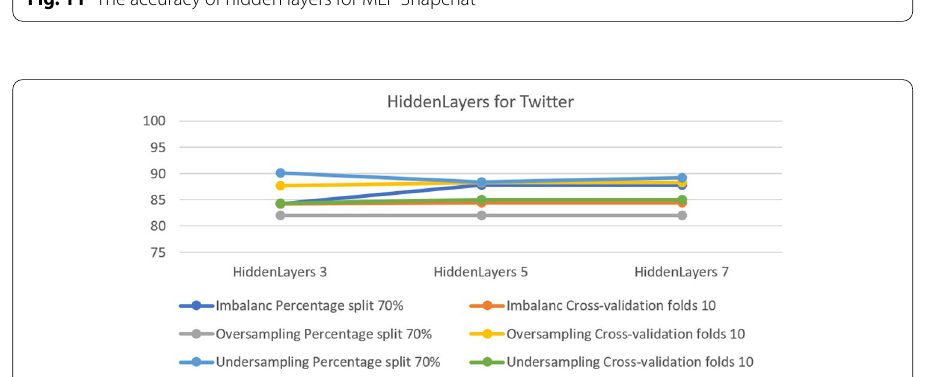
Fig. 12 The accuracy of hidden layers for MLP